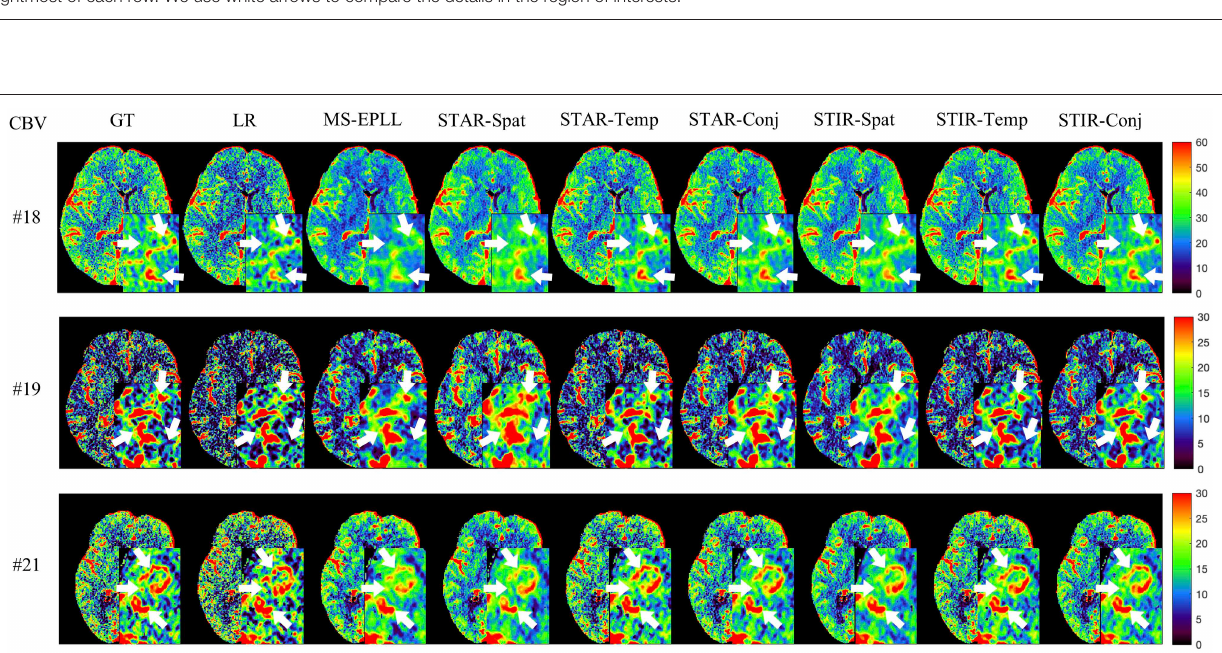
Frontiers in Neurology |